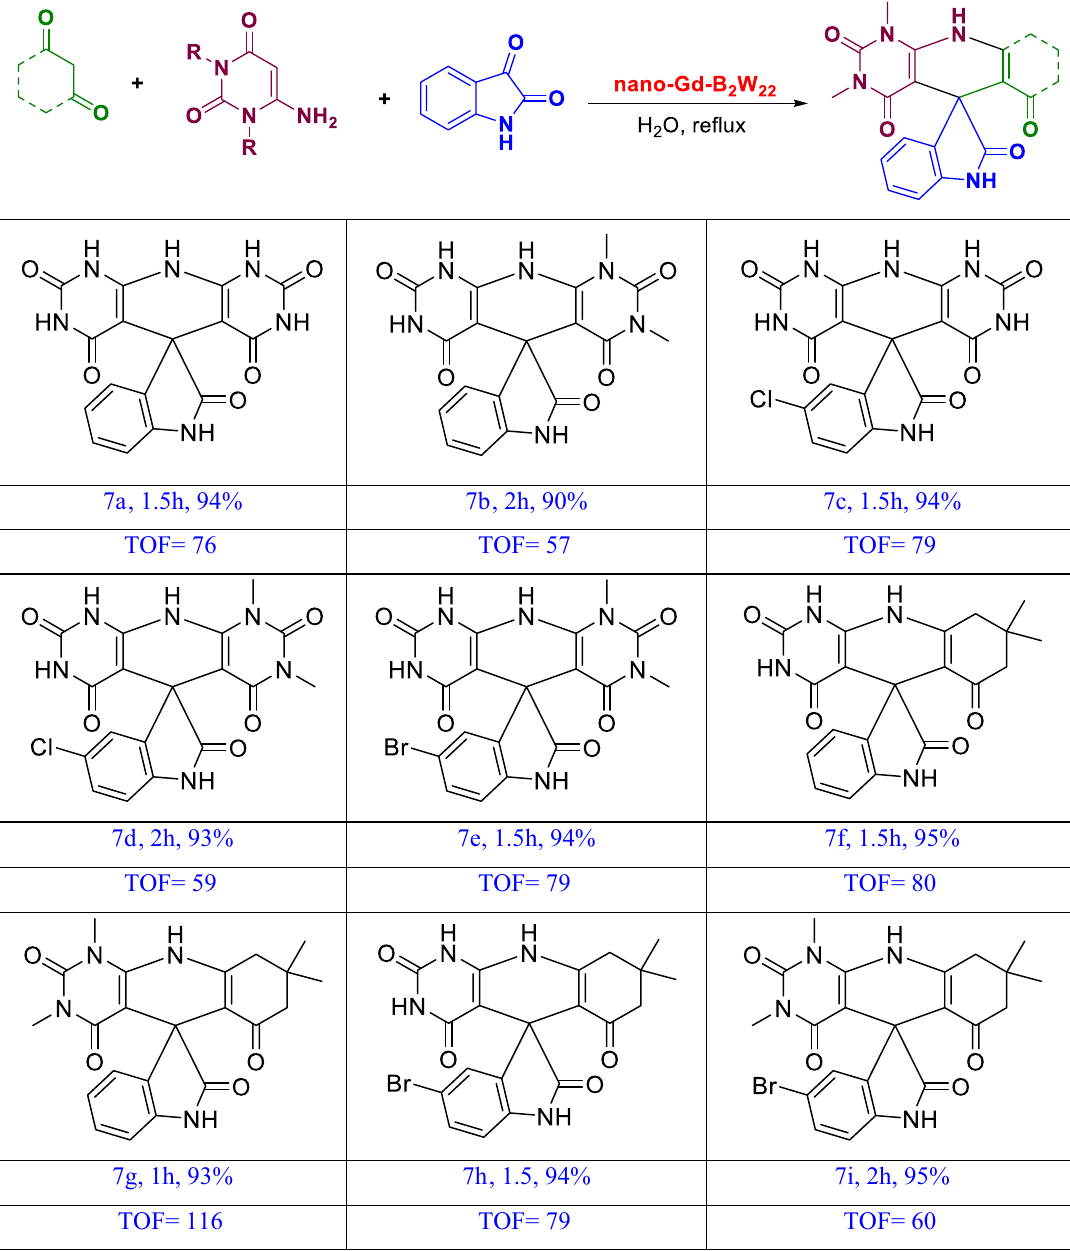
Table 4. Synthesis of uracil-fused spirooxindoles 10,38,39